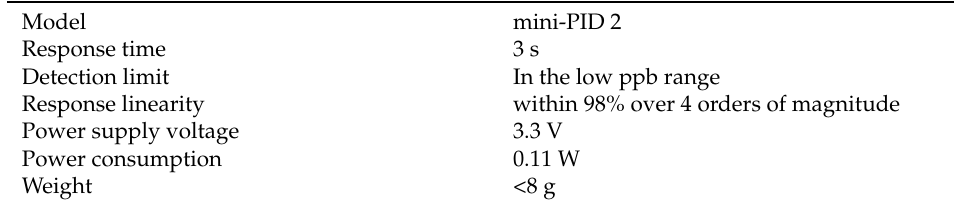
Table 2. Specifications of the PID.